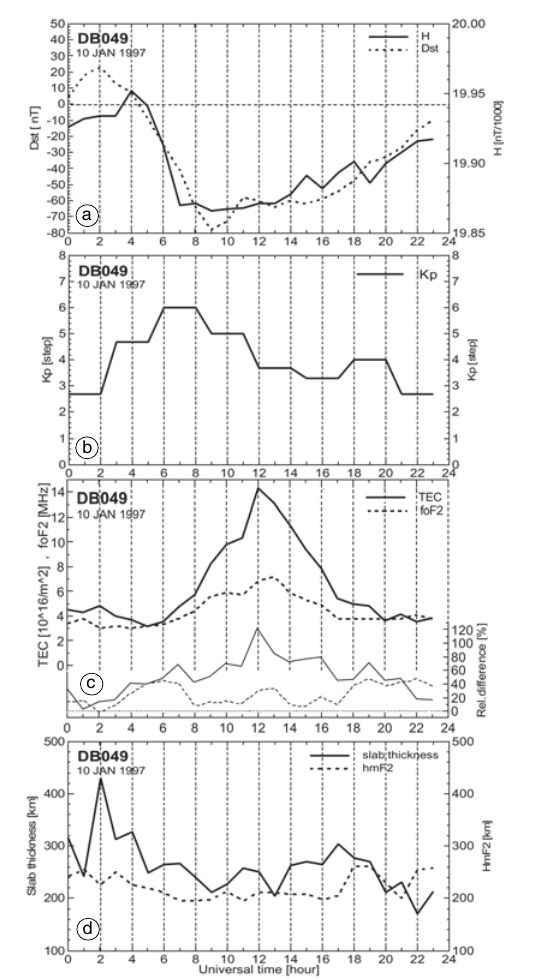
Fig. 2a-d. Ionosphere-plasmasphere response to the 10th January 1997 geomagnetic storm, as observed at the site of the Dourbes ionosonde station DB049 (4.6 ° E, 50.1 °